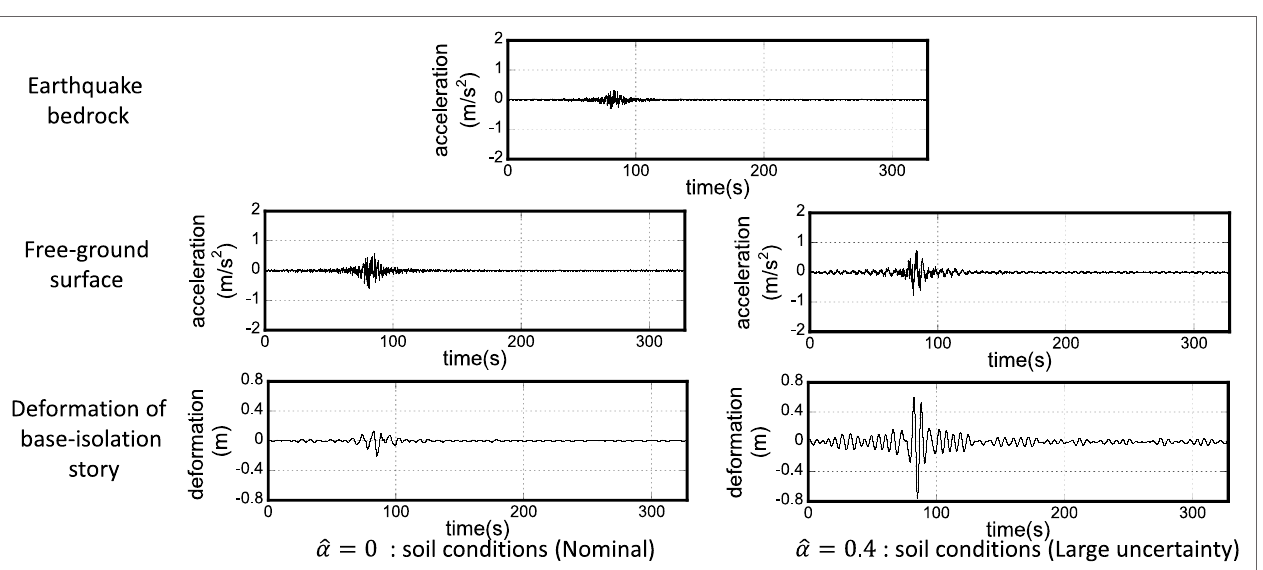
FIGURE 10 | Generated acceleration wave at earthquake bedrock, generated acceleration wave at free-ground surface, and generated deformation at base-isolation story for two uncertainty levels ^ α = 0 ; 0 : 4 of deep ground properties (Osaka area).